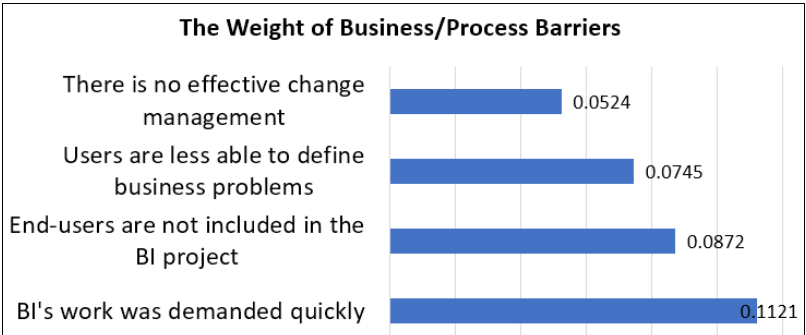
Figure 4. Weight of Barriers in Business/Process Criteria